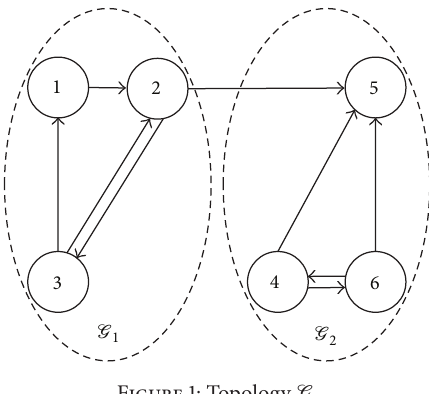
Figure 1: Topology G